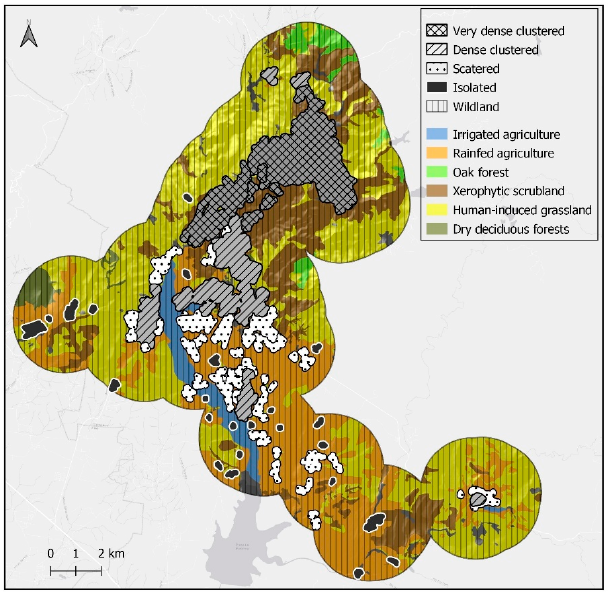
Figure 2. Map of the housing spatial patterns categories, land use, and vegetation cover in the WUI of the study area.